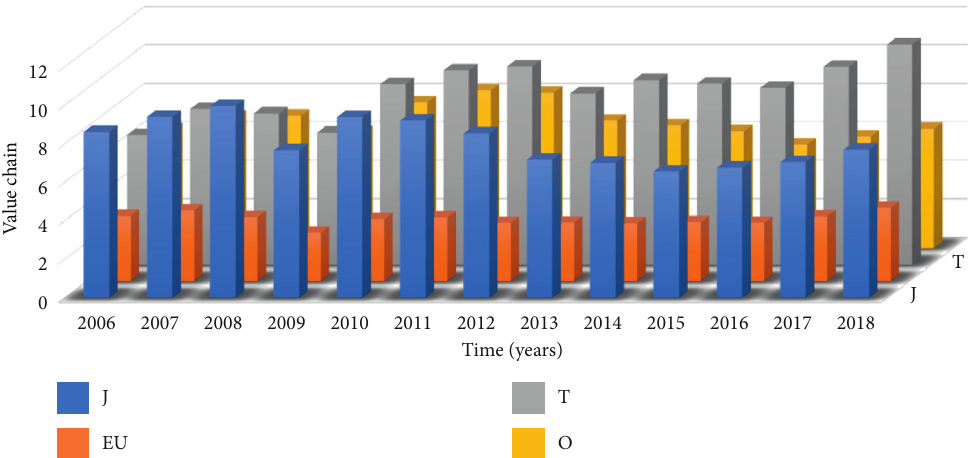
Figure 7: Cosimulation results of various